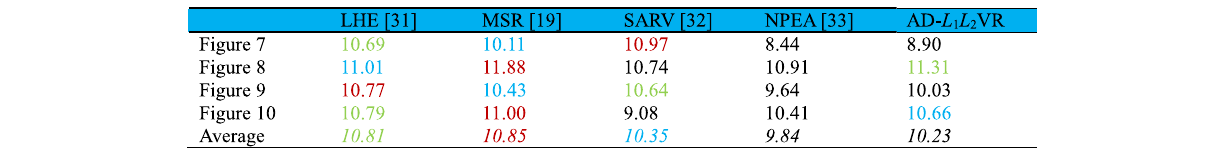
italics values are the average values that can evluate the performance of different methods more accurately. red color data represents the highest value, green color data represents the second highest, and blue color data represents the third